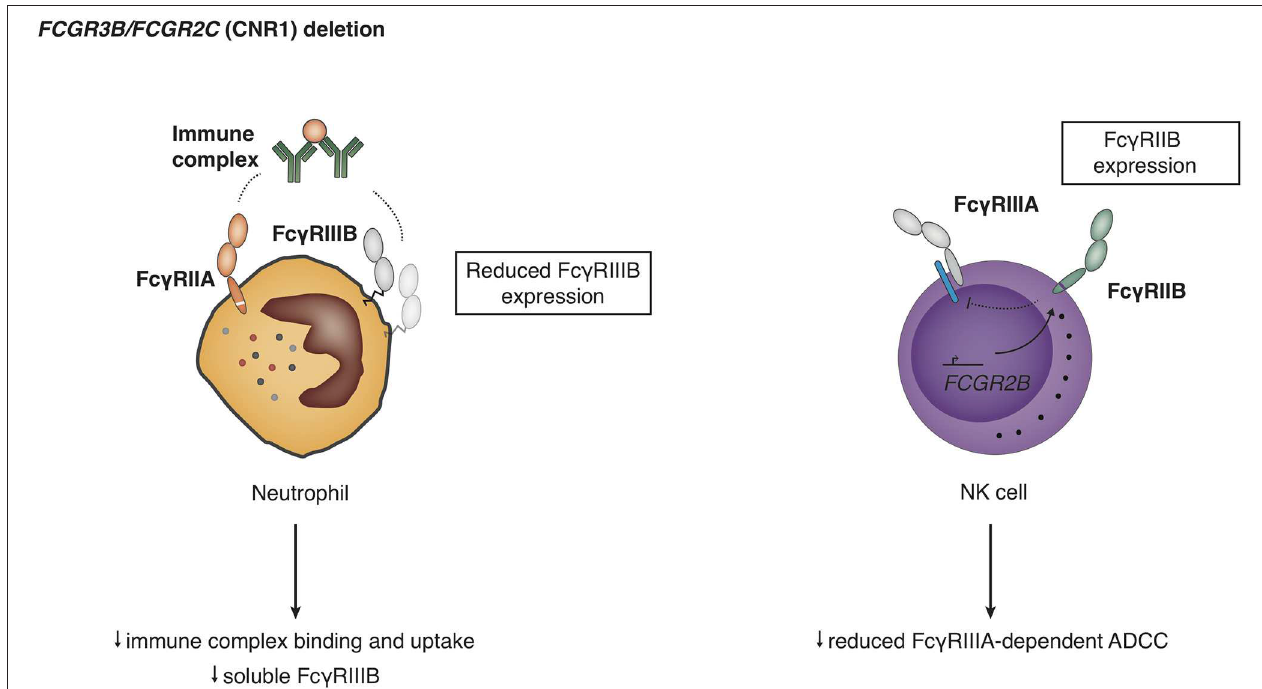
FIGURE 7 | Functional consequences of deletion in the copy number region 1 (CNR1). Detailed explanations are given in the main